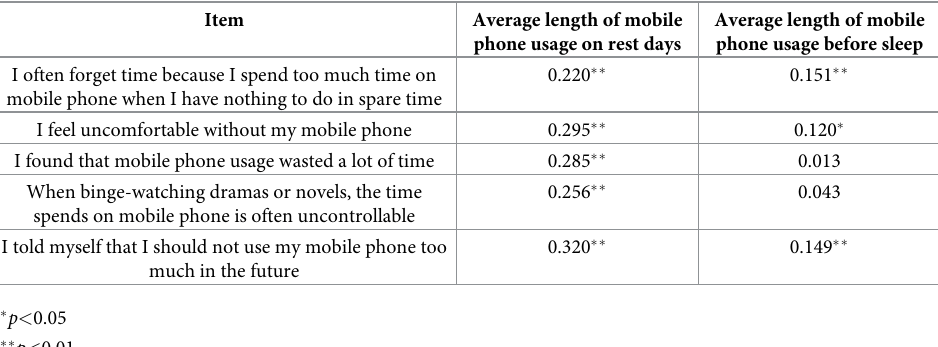
Table 9. Pearson Correlation Coefficient between mobile phone usage duration and mobile phone